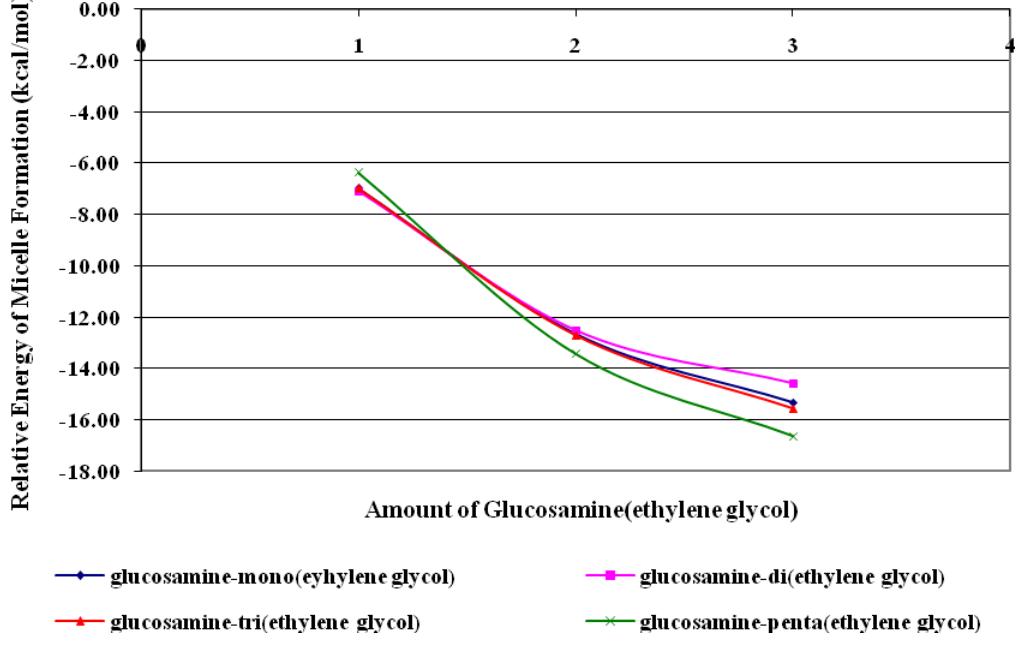
Figure 8. Relationship between the relative energy of micelle formation and the amount of glucosamine(ethylene glycol)